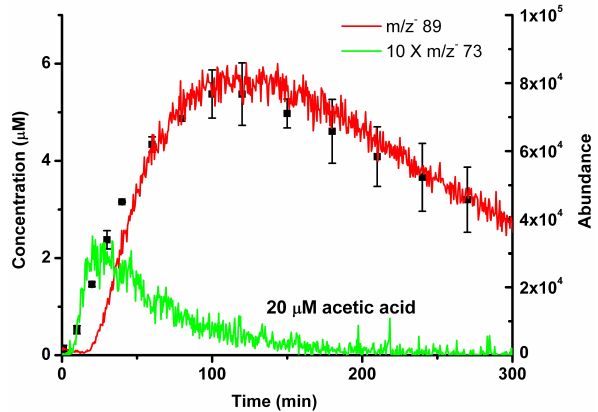
Fig. 3. Oxalic and glyoxylic acid production from acetic acid (20µM)+OH experiments. Ion abundance of oxalic acid ( m/z − 89, red line) and glyoxylic acid ( m/z − 73, green line) in negative mode ESI-MS online experiment; oxalic acid concentrations quantified by IC (black squares). Difference between IC and ESI-MS oxalic acid might be due to ionization competition.